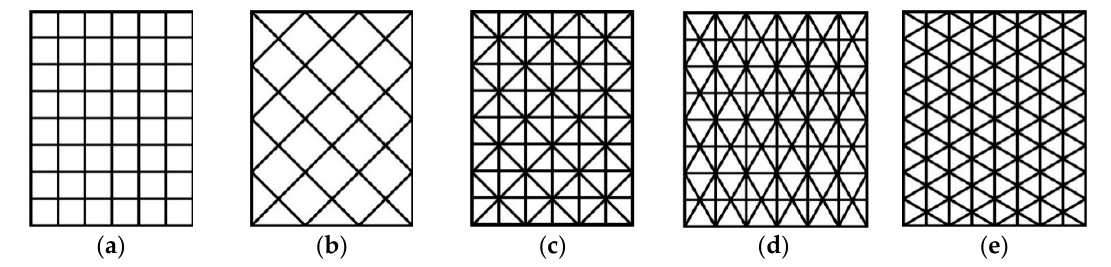
Figure 1. Schemes of grid stiffening structures: ( a ) ortho-grid, ( b ) x-grid, ( c ) bi-grid, ( d ) iso-grid type I, ( e ) iso-grid type II